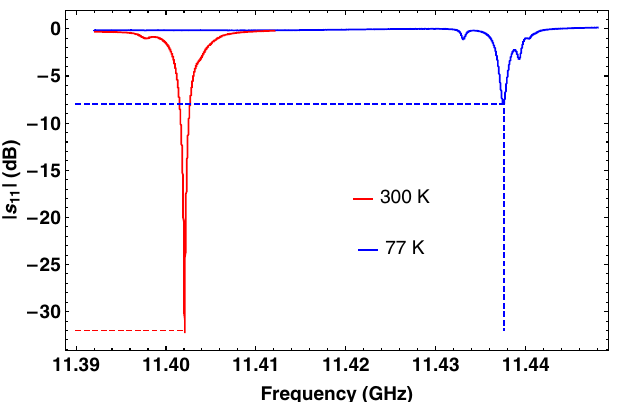
FIG. 3. The reflection coefficient at the rf input to the accel- erator at 300 and 77 K. As the accelerator structure cools down, it shrinks leading to a shift of the resonance frequency of 36 MHz. The tested linac is designed for critical coupling at 300 K, j s 11 j ¼ − 32 dB at resonance, and becomes overcoupled at 77 K, j s − 8 dB at resonance, because of the reduced surface resistance which increases the intrinsic quality factor of the accelerating cavity while the external one remains